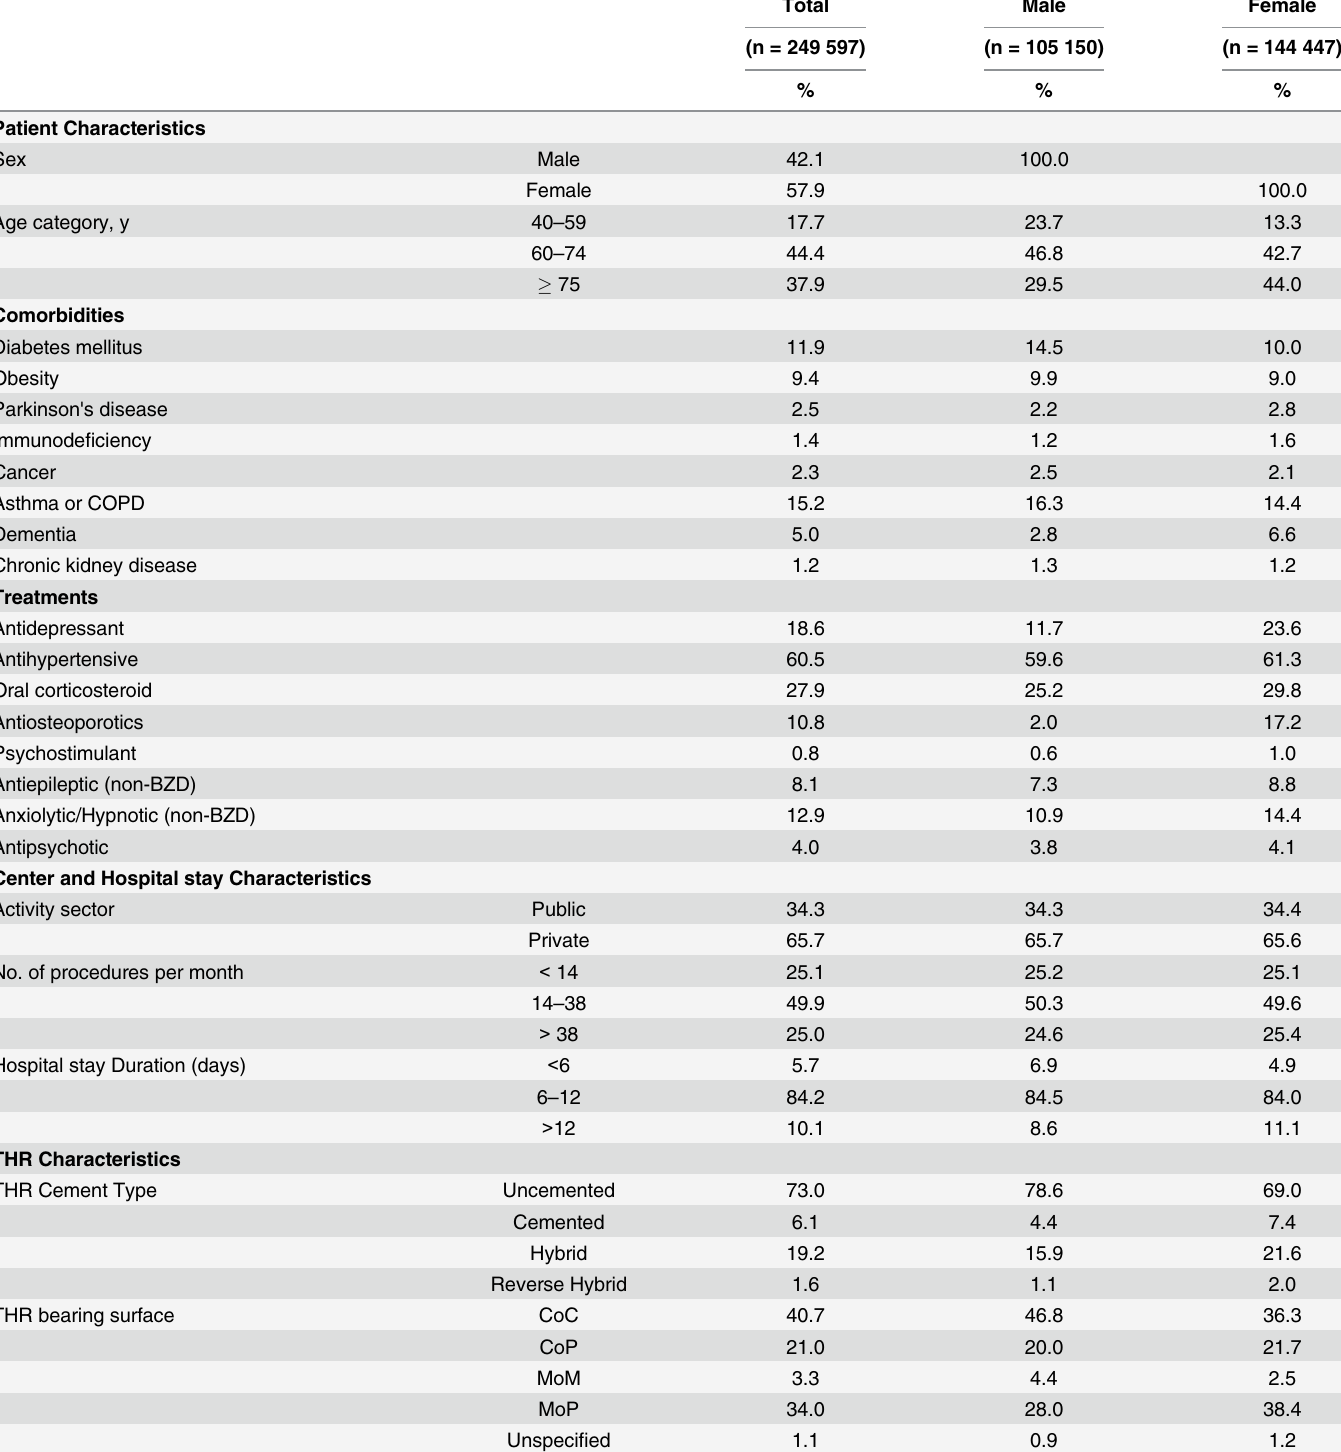
Table 1. Baseline Characteristics of enrolled patients, Hospital Stays and THR according to sex.